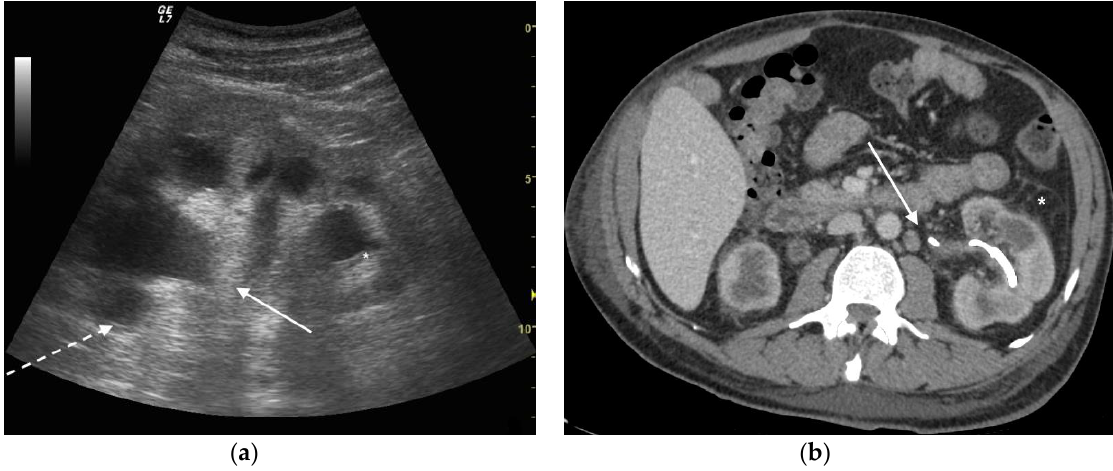
Figure 3. A 73 years old septic male patient. US longitudinal view of left kidney ( a , b ) showing hydronephrosis with parietal thickening of inferior calyceal group (*), dense peripheral echoes within the calyceal system (white arrow) with acoustic shadowing at low-gain indicating gas-forming infection, perirenal suffusion was detected (dashed arrow). Axial CT ( b ) with intravenous contrast in cortical-medullary phase after stent placement (white arrow), showing drainage of calico-pelvic system. Mild perirenal fat stranding (*).